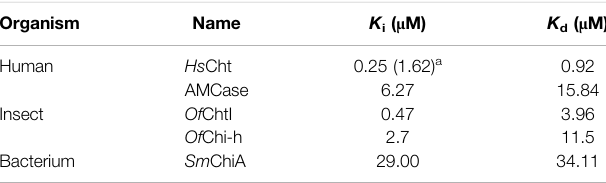
TABLE 1 | Inhibitory activities and binding af fi nities of the compounds toward different GH18 chitinases.